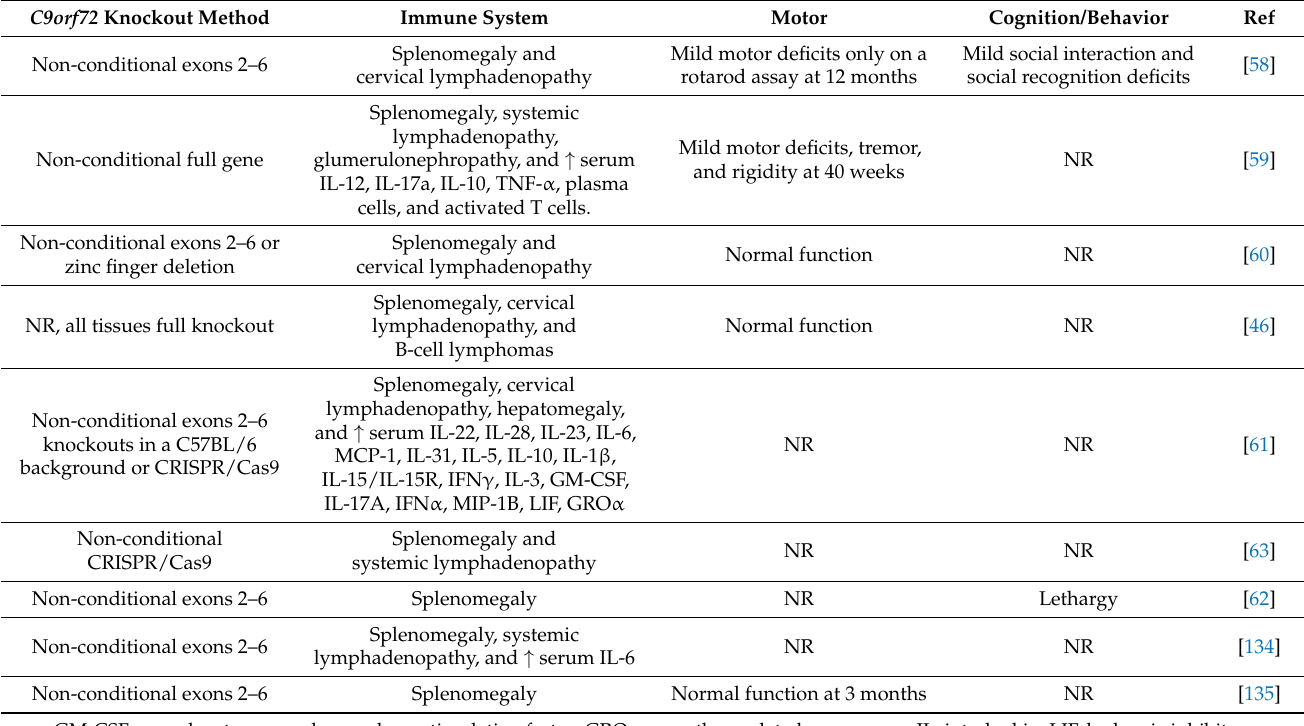
Table 1. Immune system dysregulation phenotypes in homozygotes in mouse models of C9orf72 loss of function. C9orf72 Knockout